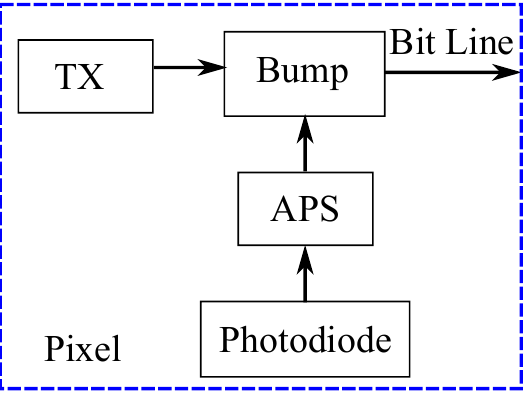
Figure 41. An edge detection circuit directly connected to a photodiode.